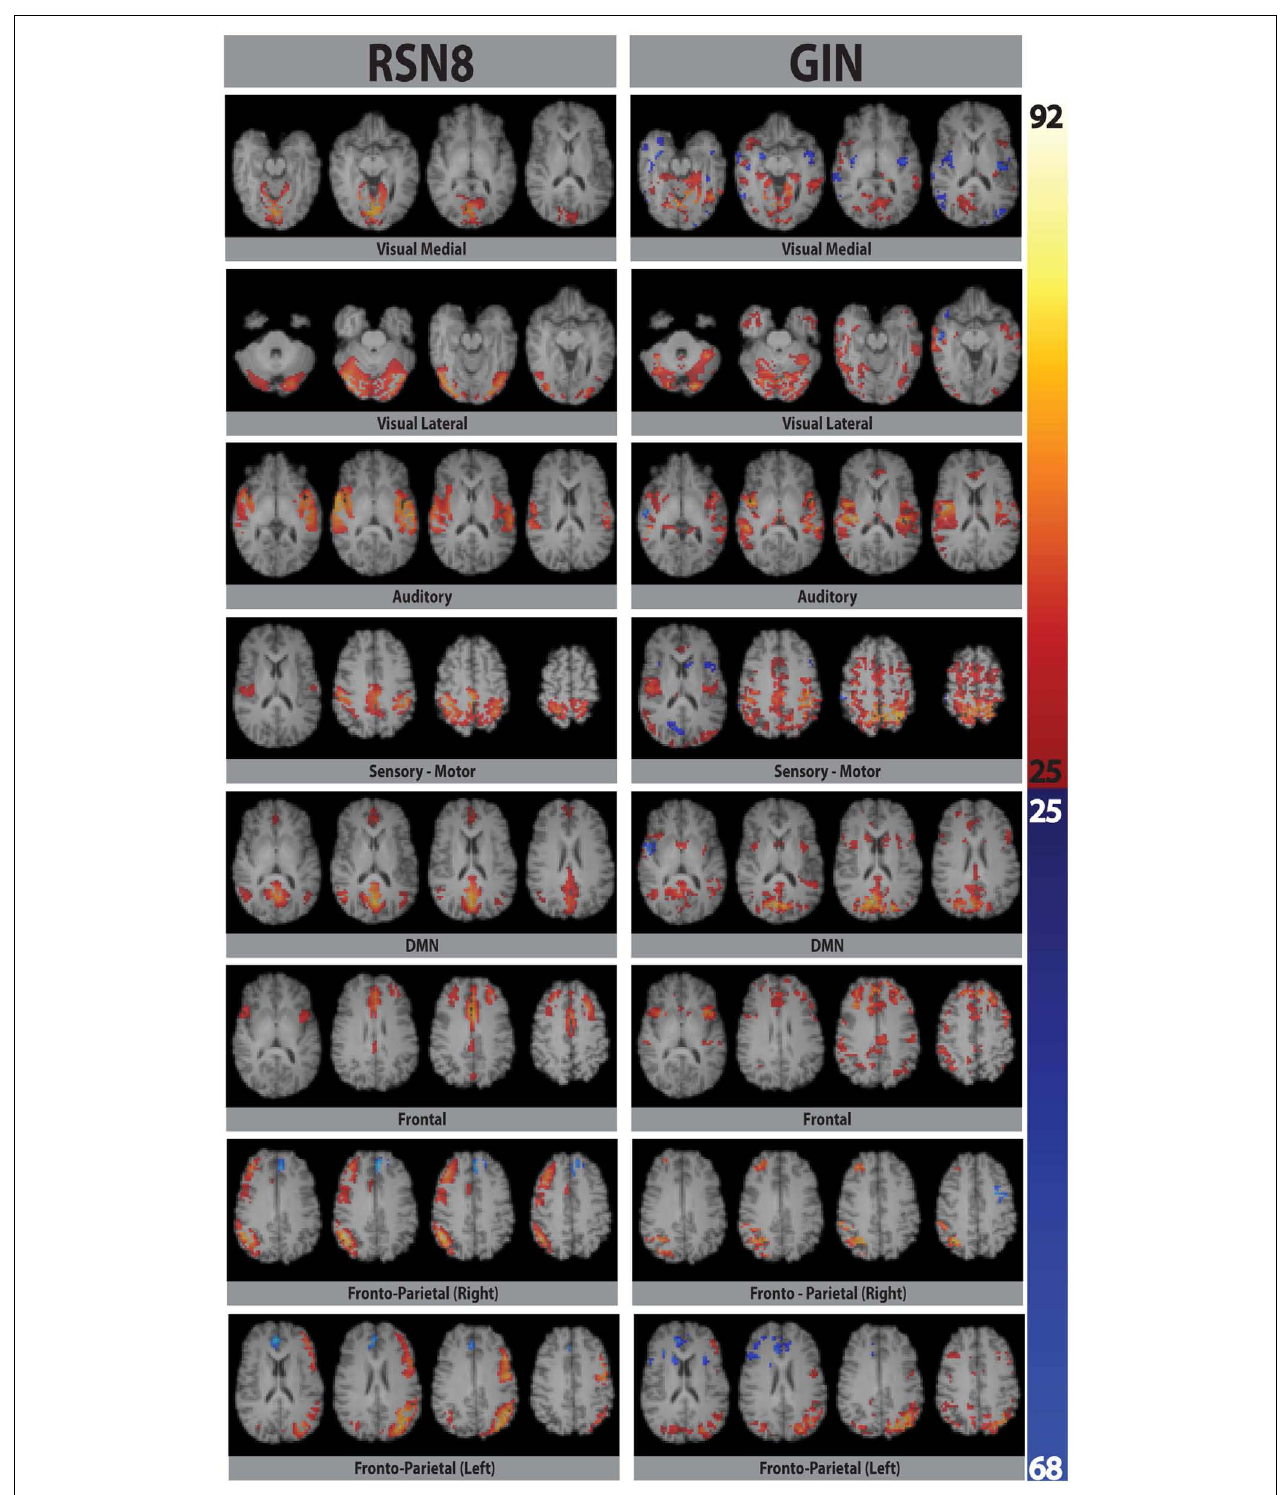
FIGURE 2 | Eight prototypical RSNs (Beckmann et al., 2005) and the corresponding dual regression maps (in z -scores) overlaid on the four most representative slices for a single subject .